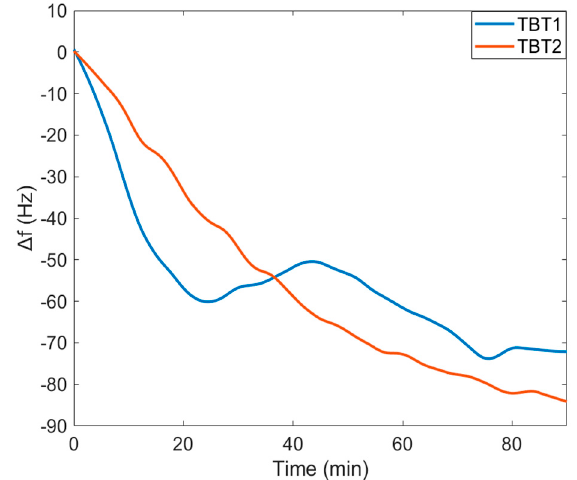
Figure 4. Resonance frequency shifts ( ∆ f ) observed during TBT1 and TBT2 peptide immobilization on the MPS − coated QCM surface.